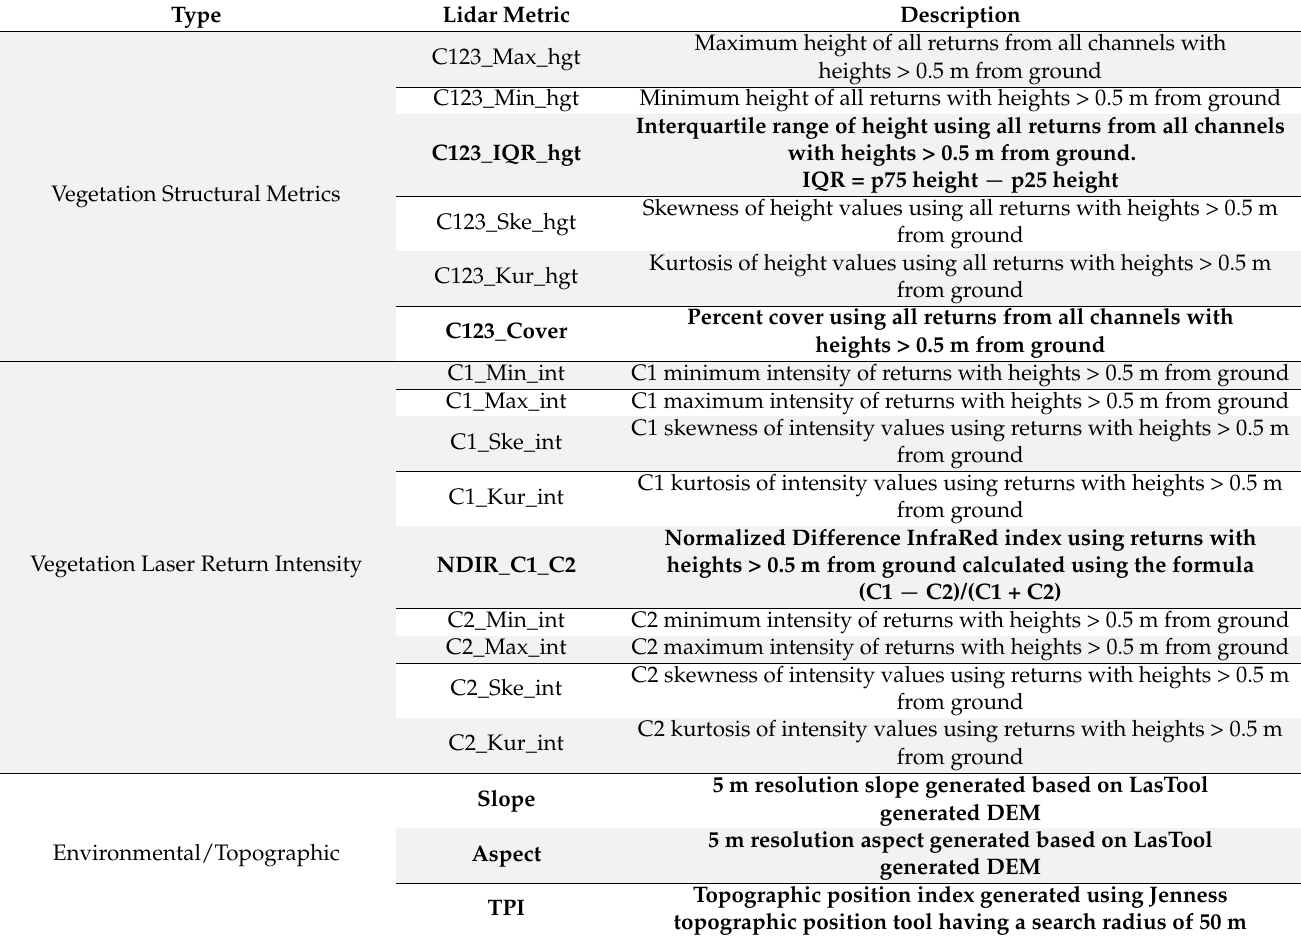
Table 1. Lidar metrics derived for identifying shrubs and trees using return height above ground greater than 0.5 m. Lidar metrics in bold were used in the final model based on their importance. Other metrics were also generated but were not included in the forest-based classification (described below) because they were highly auto-correlated (Pearson’s correlation ≥ 0.60). All metrics generated had a cell resolution of 2 m 2 , except for slope and aspect, which had a resolution of 5 m 2 , resampled to 2 m 2 for the random forest classification. C1 = 1550 nm (shortwave infrared, SWIR); C2 = 1064 nm (near infrared, NIR); C3 = 532 nm (green).